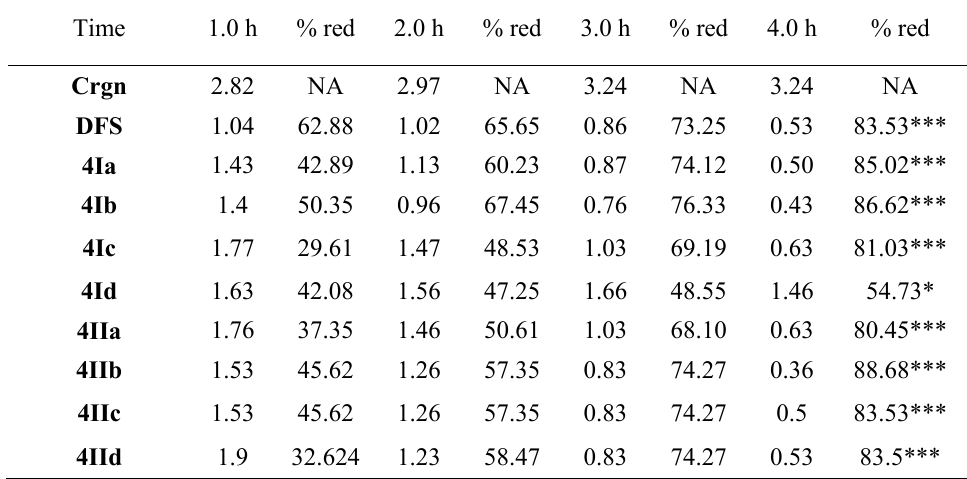
Table 2. Anti -inflammatory activity of newly synthesized Compounds ( 4Ia-4IId